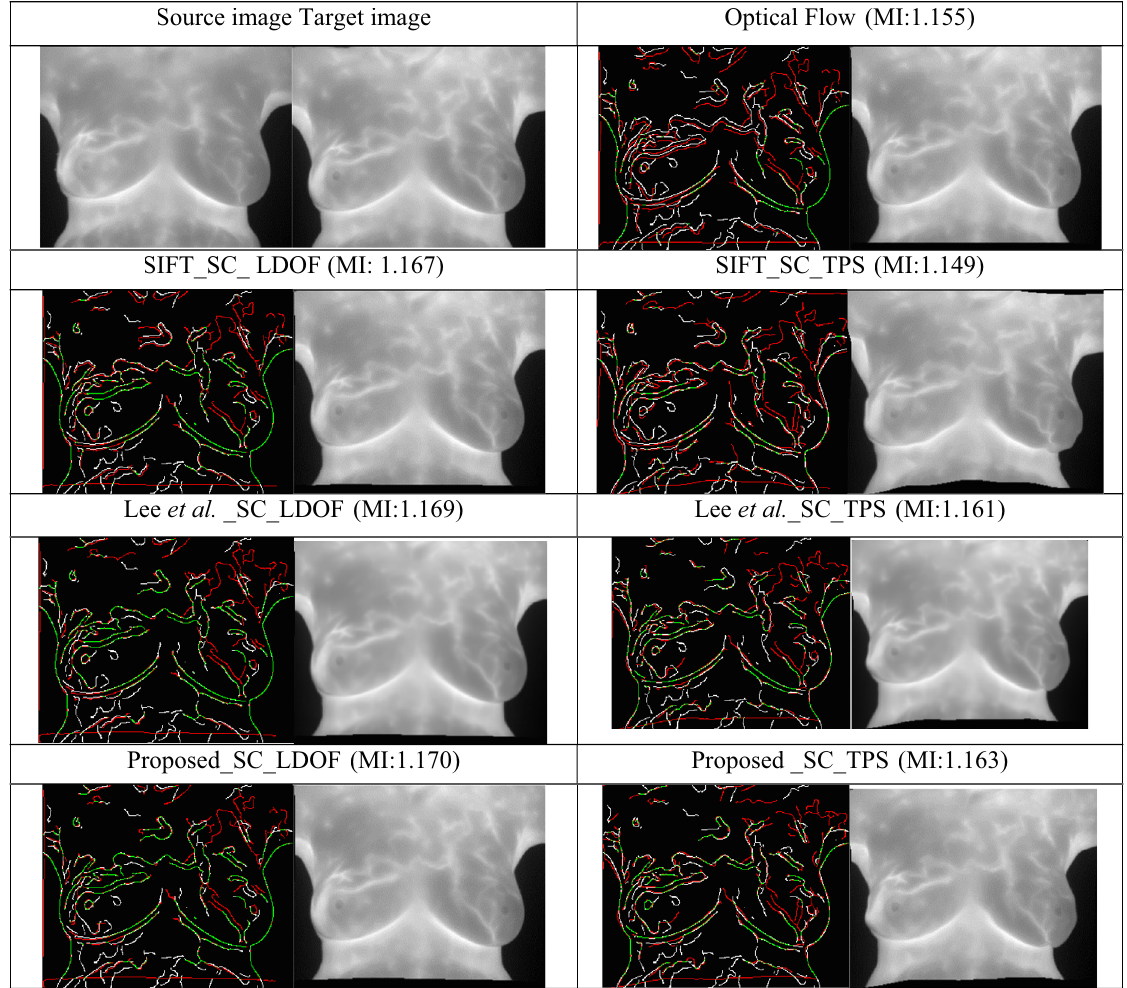
Table 3. Comparison of registration results through various methods. p.s. The words separated by underscores represent the method of “Feature points” 、 “descriptor” 、 and “transformation ” in order that used for registration; MI = mutual information; SC = Shape Context; TPS = thin plate